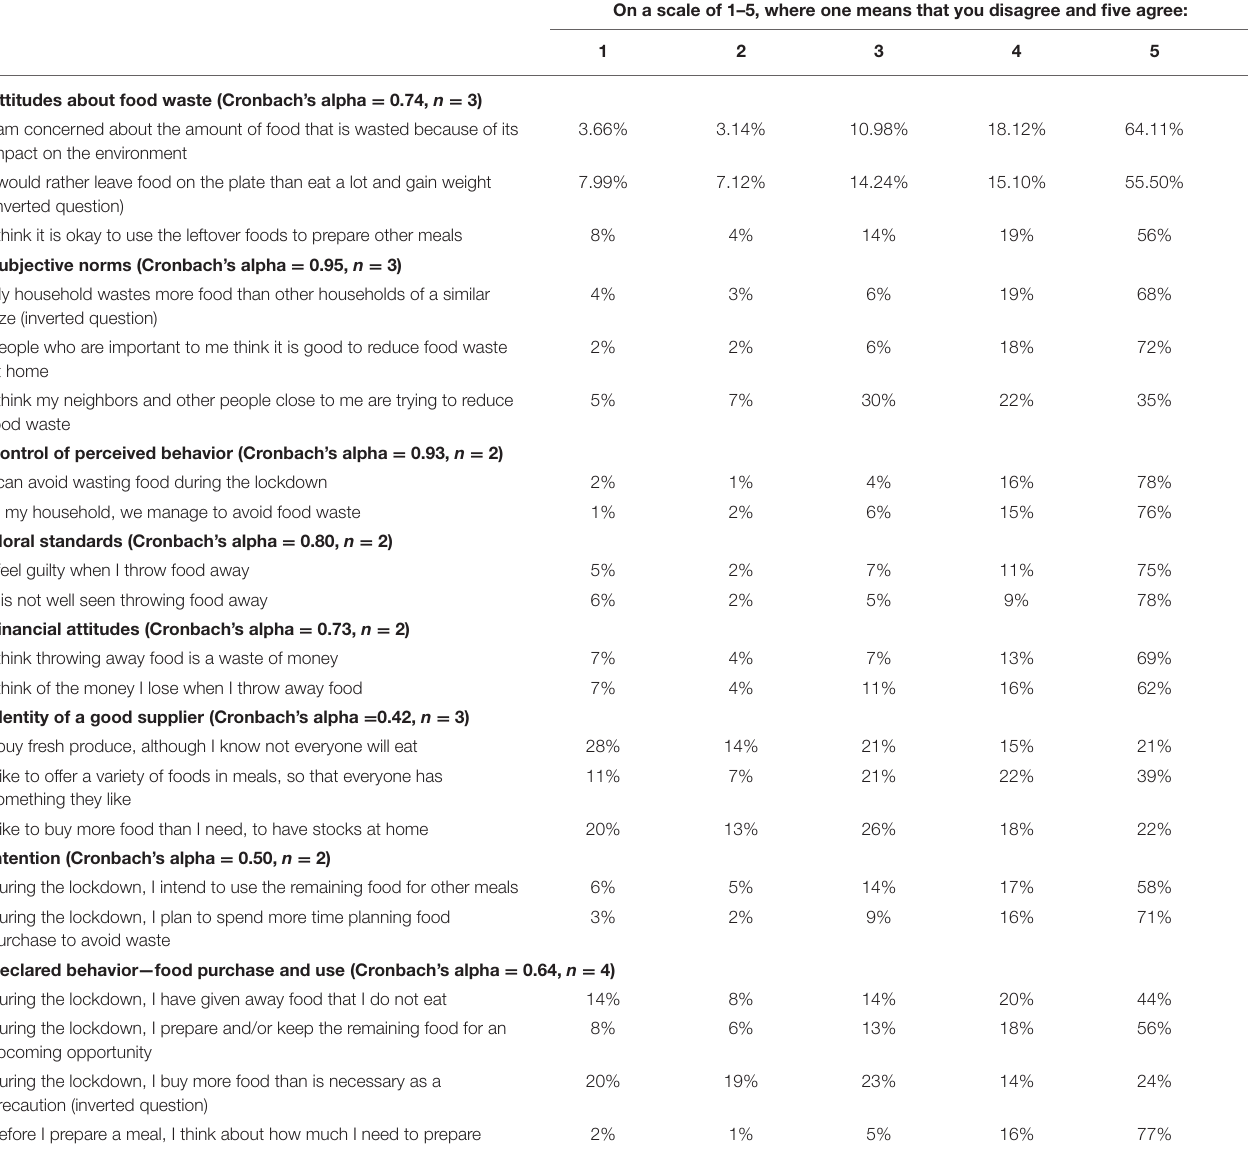
TABLE 1 | The TPB dimensions considered in this study.